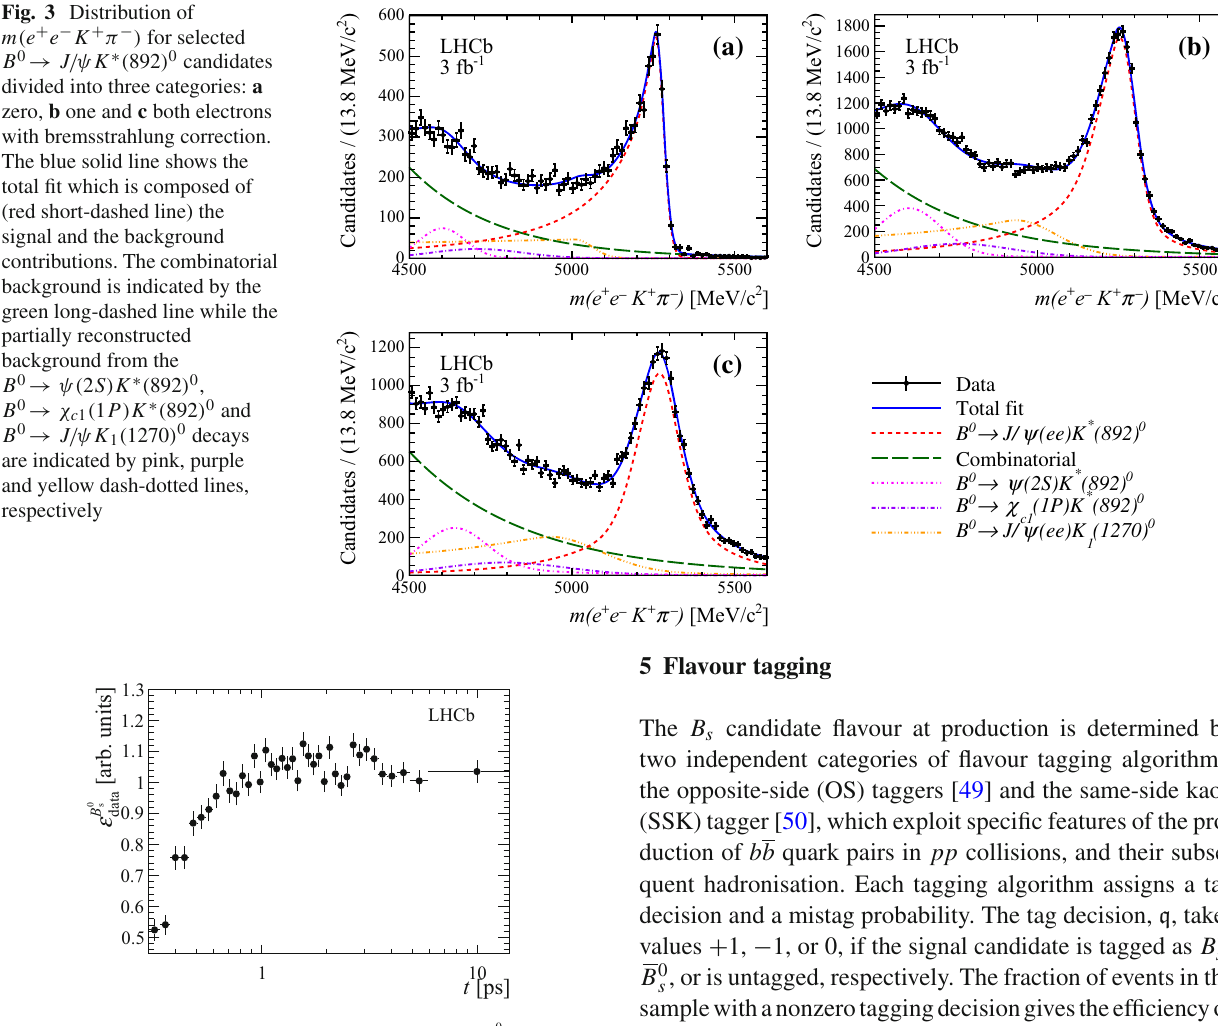
0 ( t ) ,scaled s data